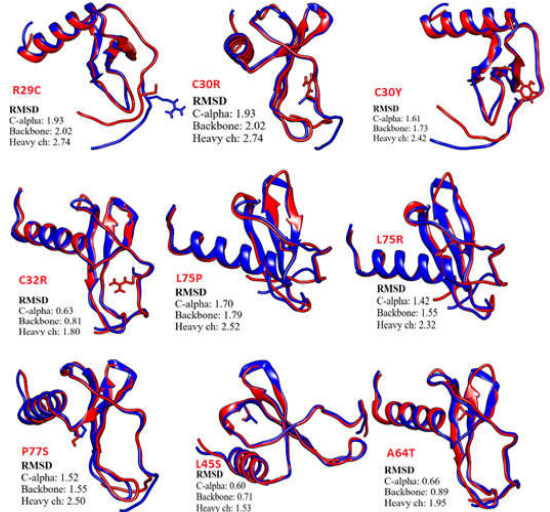
Fig. 4. Superimposition of the 3D structure of the mutant (in red) on the wild-type CXCL10 protein (in blue) using Chimera. Evaluation of the superimposed structure of the native and mutant protein models showed that almost all the monomeric structures exhibited a typical chemokine fold including a three- stranded β sheet overlaid by an α helix (for more information please refer to the main text). (The color must be used). Thus they may inhibit receptor binding of the protein and result in local and